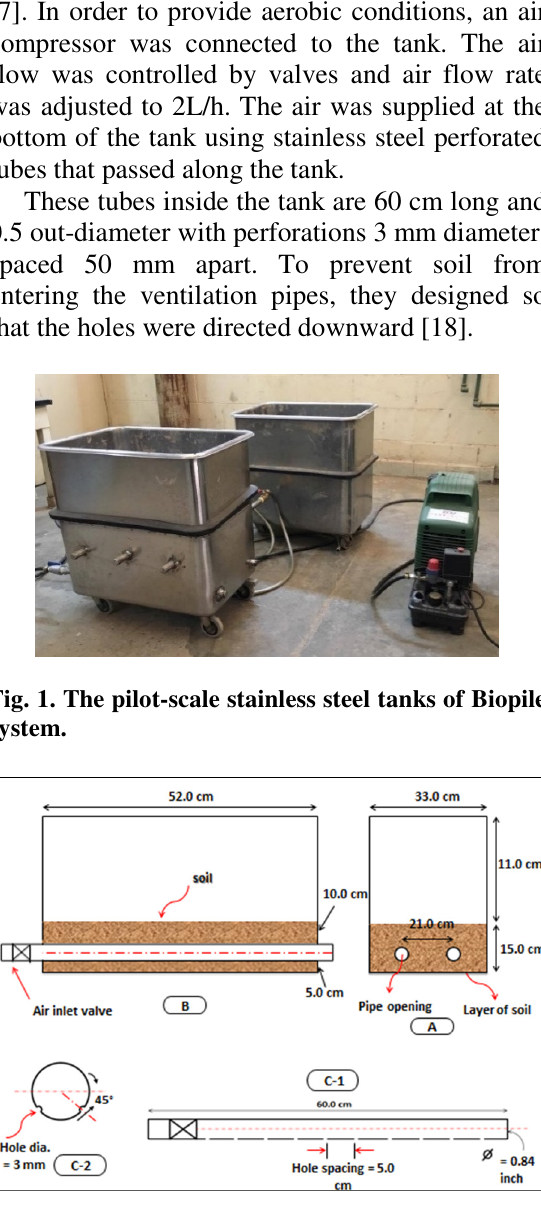
Fig. 2. the dimensions of the stainless steel Biopile system. A: front view B: side view C-1: air